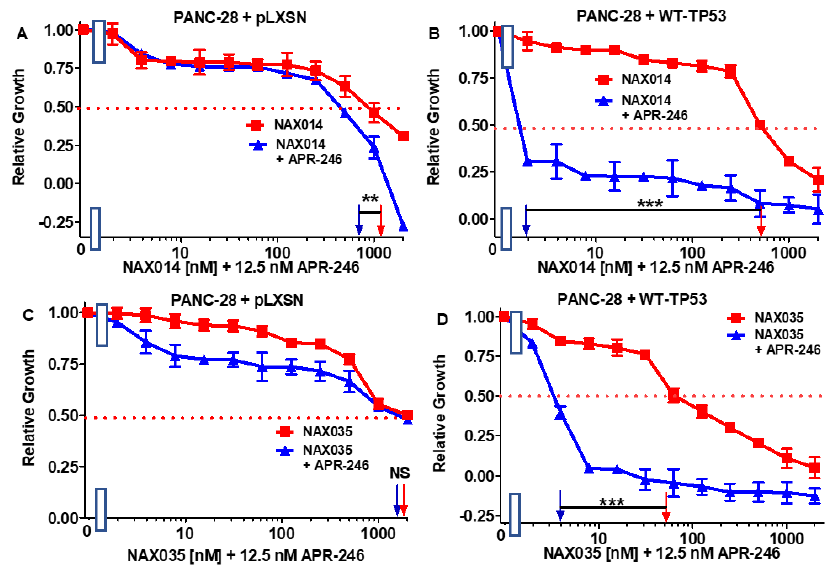
Figure 12. APR-246 enhances the effects of NAX014 greater when WT-TP53 is present in PANC-28 cells, while APR-246 enhances the effects of NAX035 in PANC-28 cells in the presence of WT-TP53 but not in the absence of WT-TP53. Panel ( A ) PANC-28 + pLXSN cells treated with different concentrations of NAX014 (red squares) or with different concentrations of NAX014 and a low dose of APR-246 (blue triangles). Panel ( B ) PANC-28 + WT-TP53 cells treated with different concentrations of NAX014 (red squares) or with different concentrations of NAX014 and a low dose of APR-246 (blue triangles). Panel ( C ) PANC-28 + pLXSN cells treated with different concentrations of NAX035 (red squares) or with different concentrations of NAX035 and a low dose of APR-246 (blue triangles). Panel ( D ) PANC-28 + WT-TP53 cells treated with different concentrations of NAX035 (red squares) or with different concentrations of NAX035 and a low dose of APR-246 (blue triangles). The measurements were repeated 3 times, and similar results were observed. *** = p < 0.0001, ** = p < 0.005, NS, not statistically significant.